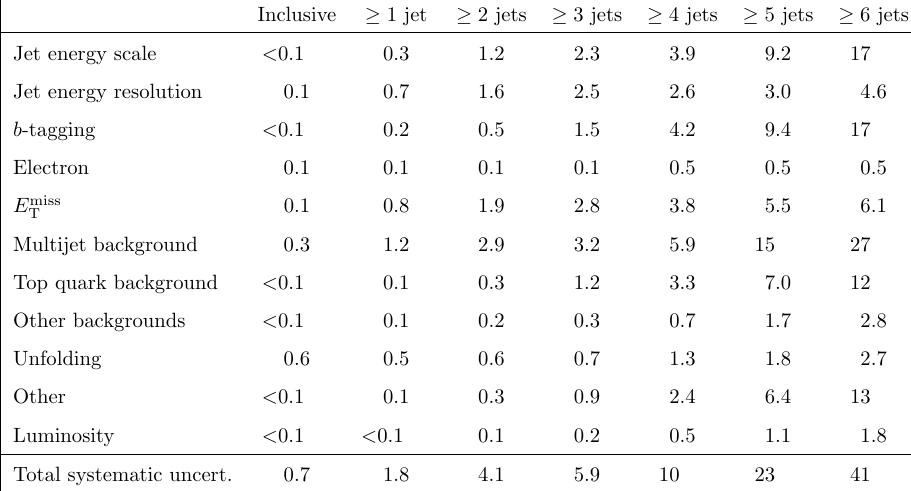
Total systematic uncert. Table 4 . Relative systematic uncertainties in the measured ( W + + jets)/( W (cid:0) + jets) cross-section ratio in percent as a function of the inclusive jet multiplicity. The uncertainty from b -tagging includes the uncertainties in the b -tagged jet identi(cid:12)cation and misidenti(cid:12)cation e(cid:14)ciencies as well as the impact of W + c; c (cid:22) c; b (cid:22) b cross sections in the extrapolation from the signal region to the (cid:12)ducial region. Other backgrounds summarises the impact of Z and diboson cross sections as well as the statistical uncertainty in the background estimates. Other combines uncertainties in the pile-up modelling and the impact of matching jets to the primary vertex.